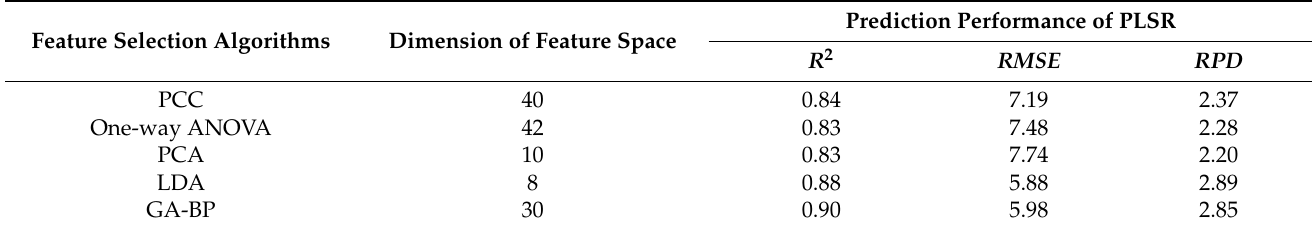
Table 8. Comparison of optimized results of different feature optimization